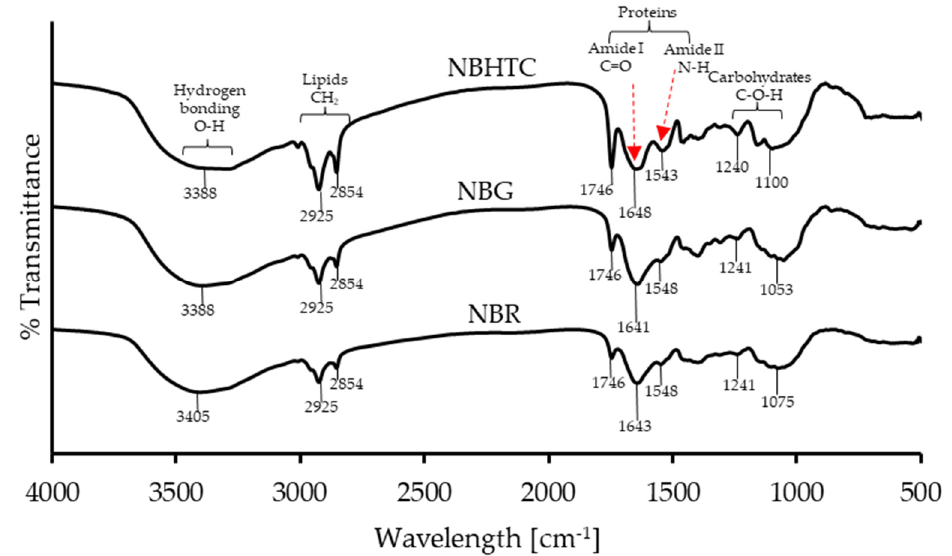
Figure 1. Fourier transform infrared spectra of Nitta bean raw, germinated, and hydrothermally cooked flours. Table 6. Functional group characteristic absorption peaks of raw, germinated, and hydrothermally cooked Nitta bean